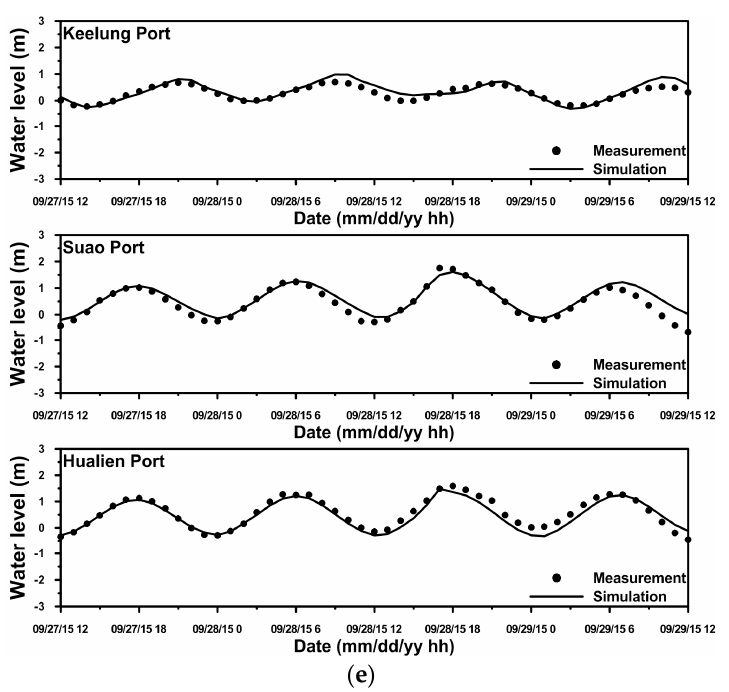
Figure 4. Comparisons of modeled and observed water levels during: ( a ) Typhoon Saola in 2012; ( b ) Typhoon Soulik in 2013; ( c ) Typhoon Matmo in 2014; ( d ) Typhoon Soudelor in 2015; and ( e ) Typhoon Dujuan in 2015.